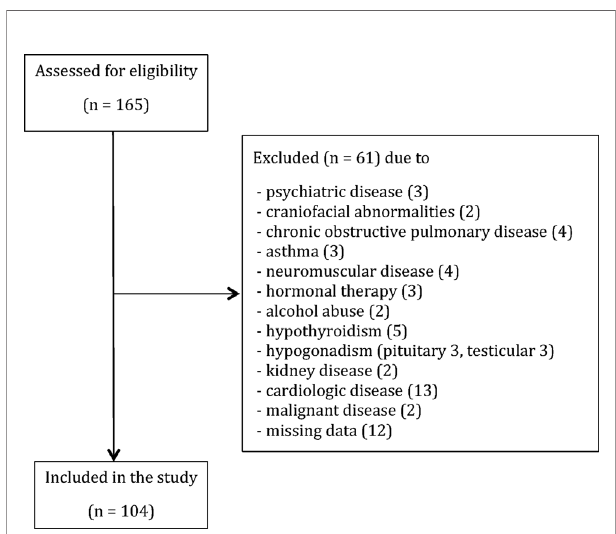
FIGURE 1 | STROBE fl owchart of the present